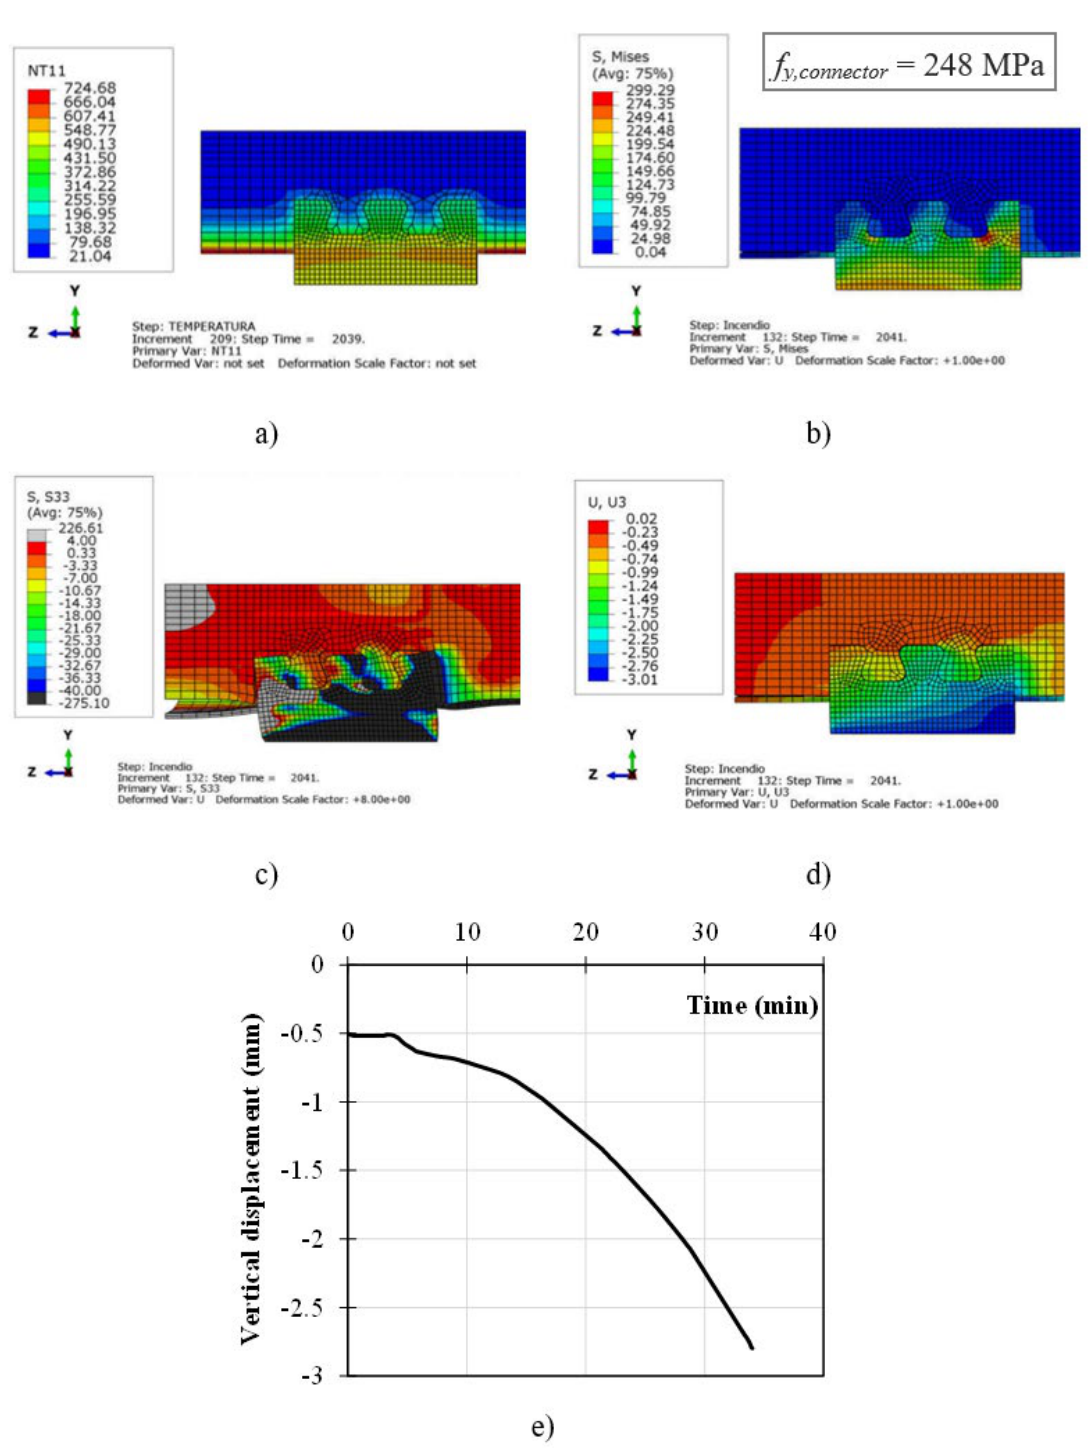
Figure 11. a) Temperature distribution, b) von Mises stresses, c) concrete tensile stresses, d) deformed configuration and e) displacement of the central point of the external surface of the connector of 400 mm diameter CFCCs with Crestbond shear connector for the loading level of